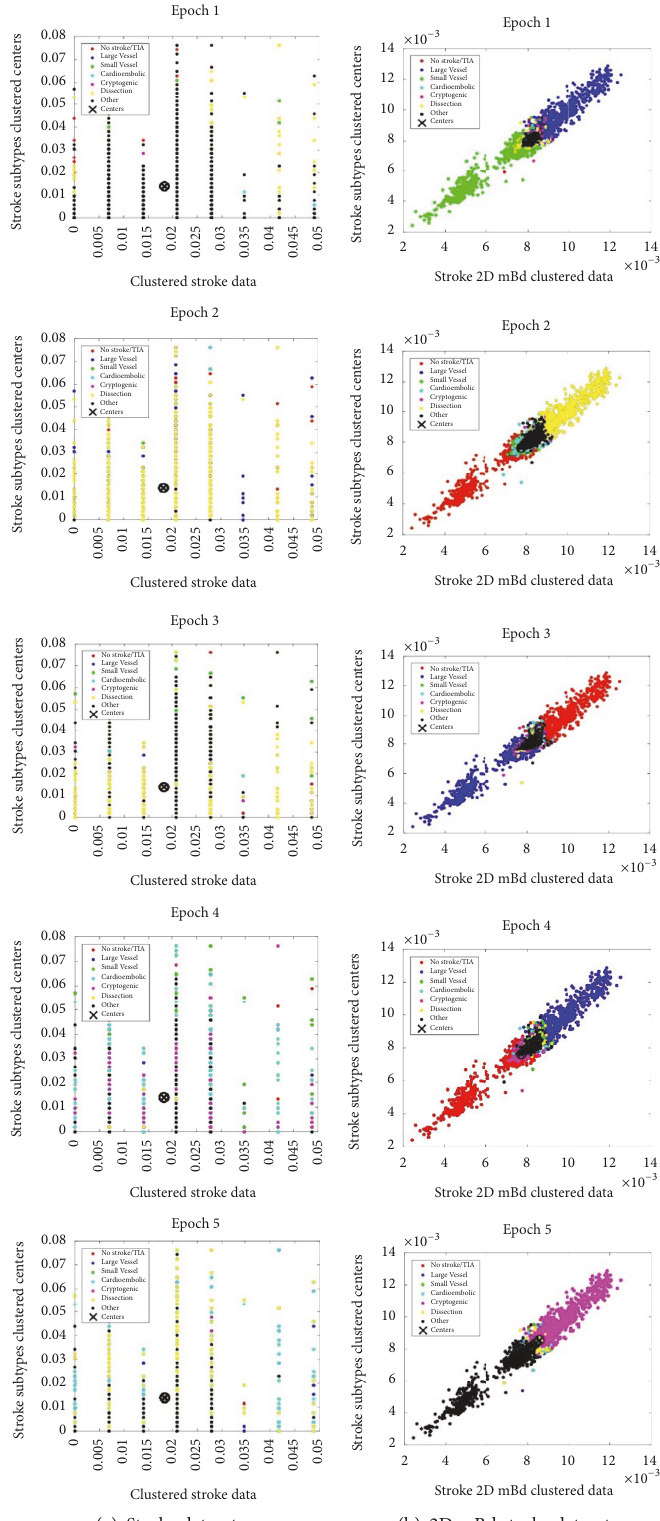
Figure 6: The clustering analyses of FCM algorithm based on the